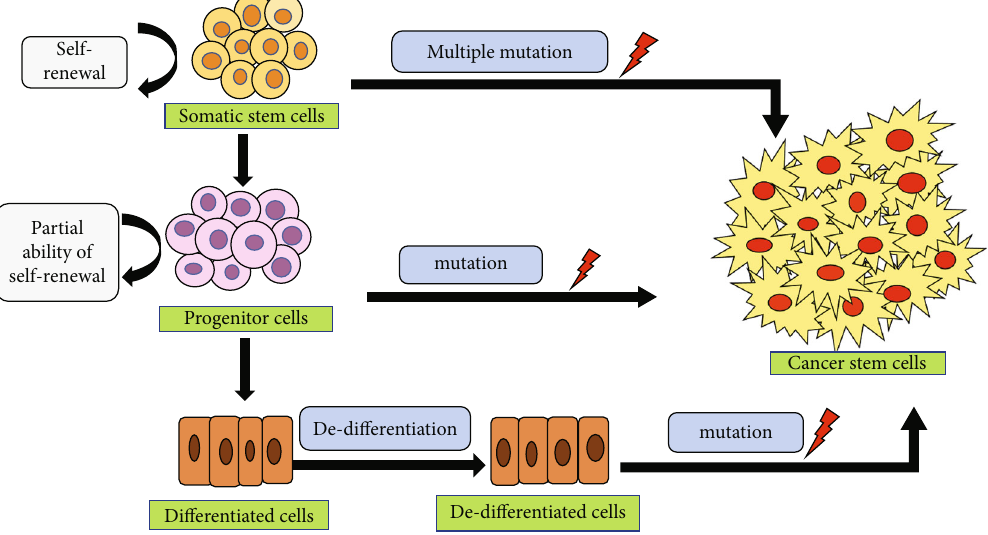
Figure 1: Theories of origin of cancer stem cells. There are three possible theories: (i) CSCs could have possibly originated either from normal stem cells when they underwent mutation or oncogenic transformation, (ii) from progenitor cells who also undergone mutations, and (iii) from the fully di ff erentiated cells that undergone several mutations via dedi ff erentiation (curved black arrows indicate self- renewal, while the straight arrows indicate the expression promotion). Table 1: Similarities between NSCs and CSCs [5, 7, 9, 10].